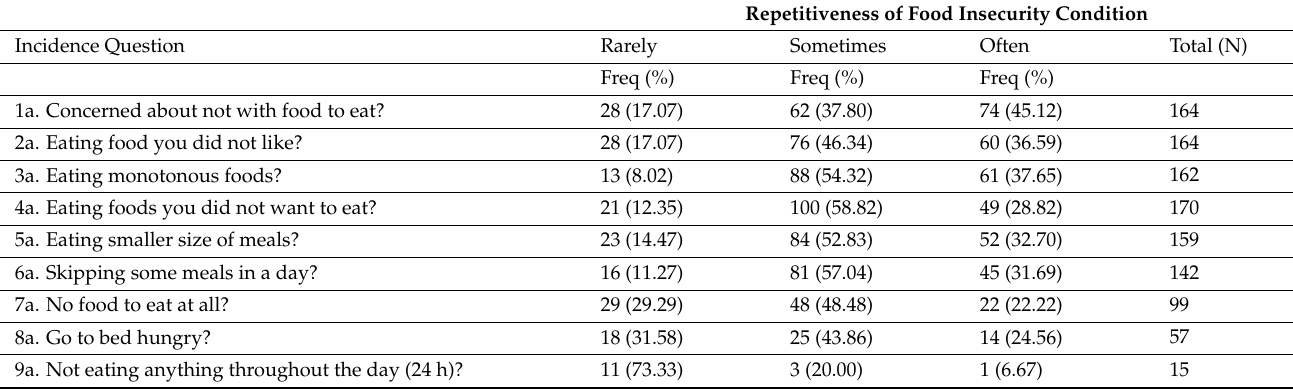
Table 5. Distribution of farming households based on repetitiveness of food insecurity conditions. Repetitiveness of Food Insecurity Condition